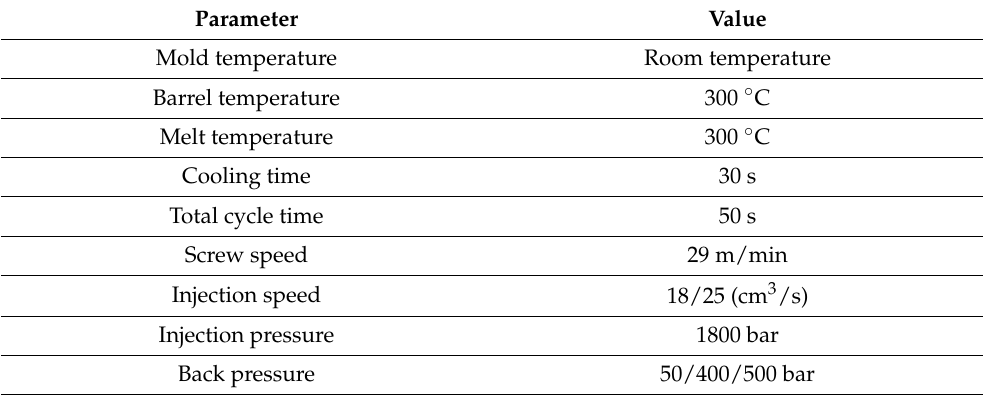
Table 3. Injection molding parameters employed to manufacture the